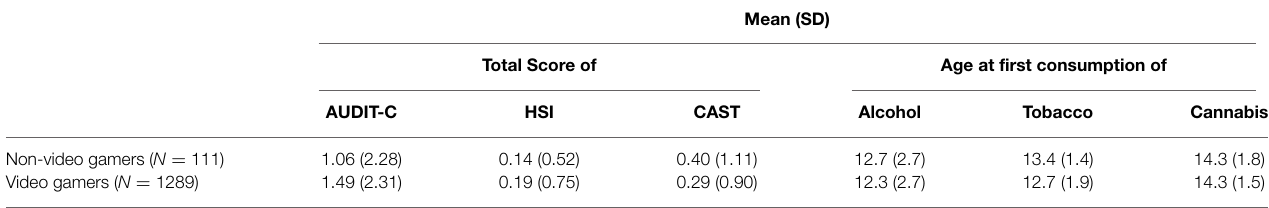
TABLE 2 | Results of AUDIT-C, HSI, and CAST, and mean age at first consumption.